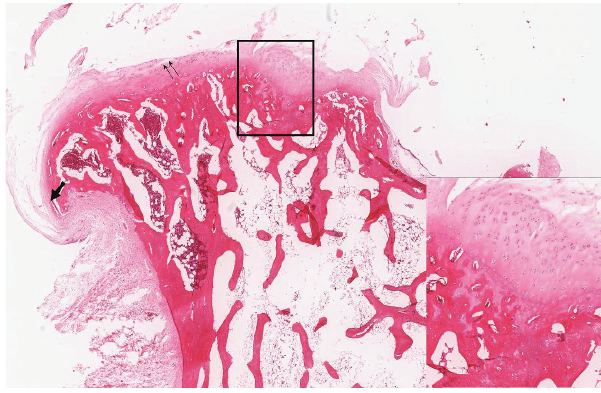
Figure 4 - Group B specimen. Image shows a continuous surface and erosion of the regenerated hyaline cartilage (insert) in the central zone of the original defect area (area within the orange line). A cystic space (arrow) that was filled with granulation tissue in the subchondral area (blue line) with sclerosing change is shown (H &